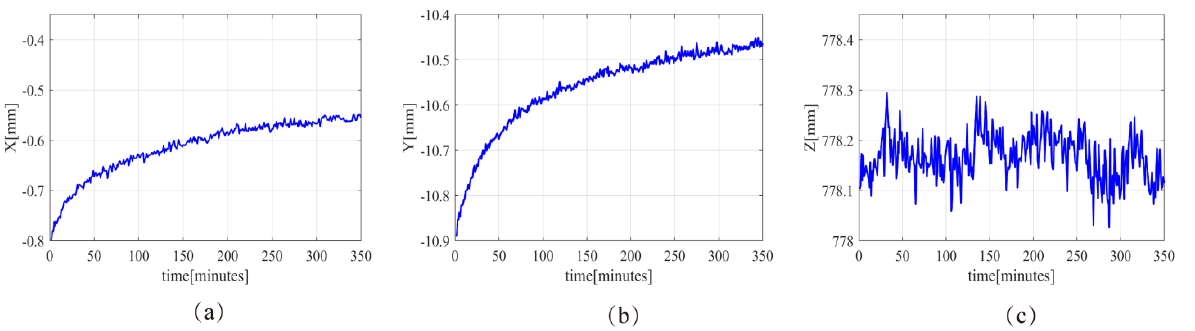
Figure 9. Three-dimensional coordinates of the center of the table tennis ball point cloud using the sphere fitting (a) X coordinate; (b) Y coordinate; (c) Z coordinate.